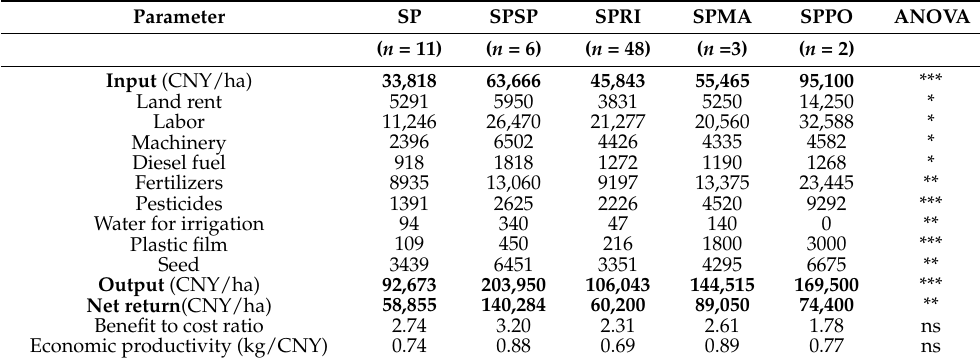
Table 4. Economic input and output for five sweet-potato-based cropping systems in Guangdong